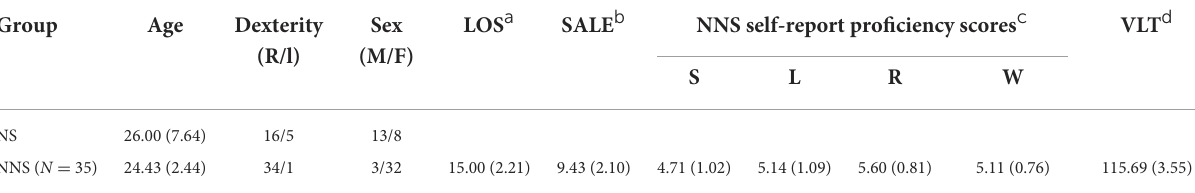
TABLE 2 Biographical information for the participants included in the